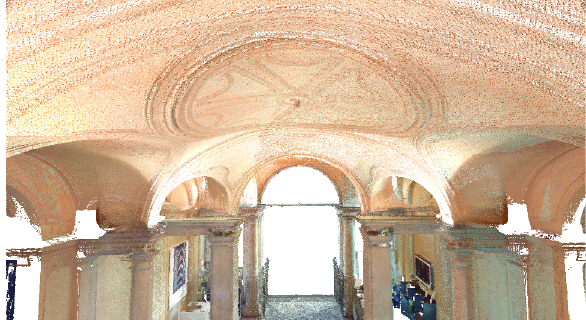
Figure 3 . Point cloud of Palazzo Mazzonis atrium. Scan: M. C. López González; processing: F. Natta.